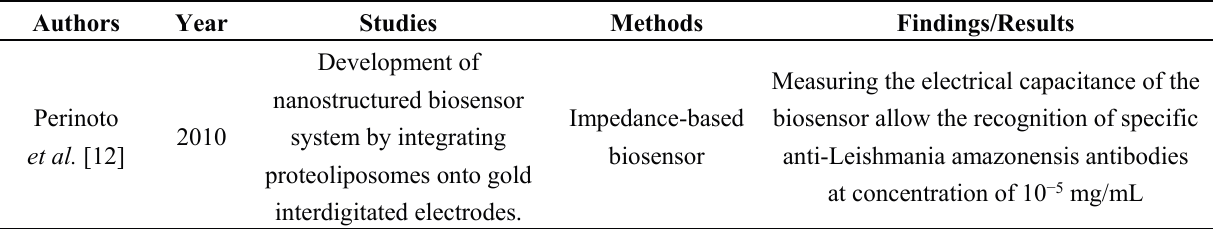
Table 11. Summary of the biomedical engineering technique in Leishmaniasis